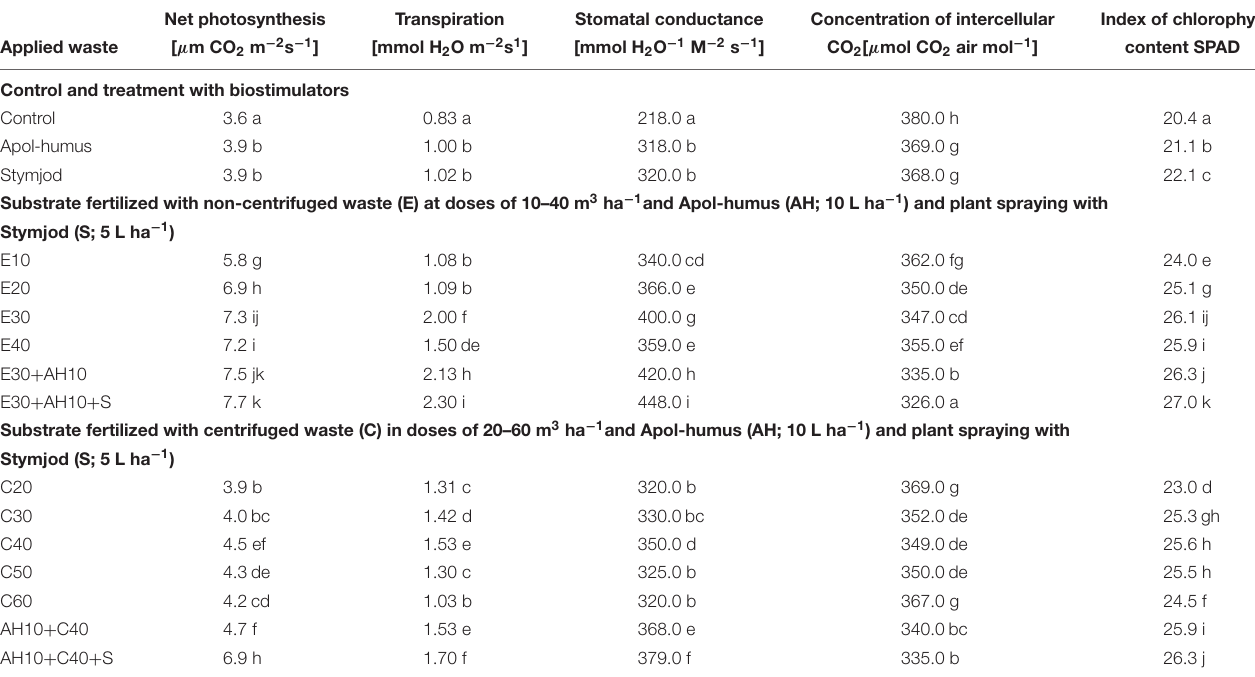
TABLE 2 | Parameters of gas exchange and index of chlorophyll content in sorghum leaves of plant cultivated in pots and fertilized with liquid, non-centrifuged and centrifuged waste from a biomass biodigestion to methane, Apol-humus and Stymjod. Net